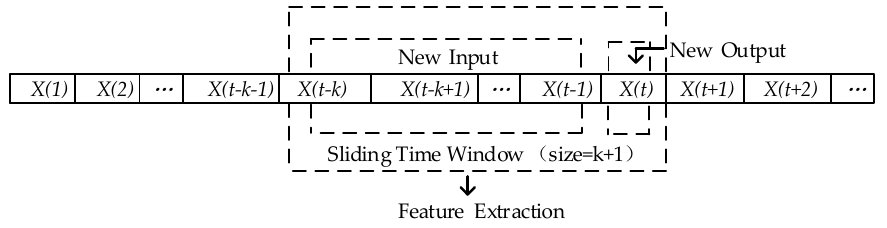
Figure 7. New sequence data based on Sliding Time Window.